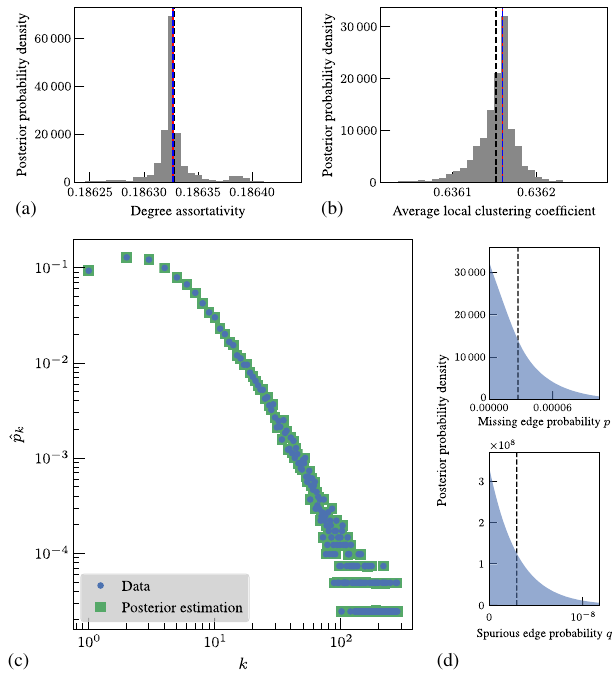
FIG. 12. Reconstruction statisticsforthe coauthorshipnetworkof arXiv.org. (a) Posterior distribution of the degree assortativity coefficient. The black dashed line marks the mean of the distribu- tion, and the blue dashed line the value obtained for the MMP ˆ A . The red solid line marks the value computed directly estimate from the data.(b) The same as(a)butfor the averagelocal clustering coefficient. (c) Measured and estimated degree distributions. (d) Posterior distributions for the error probabilities p and q